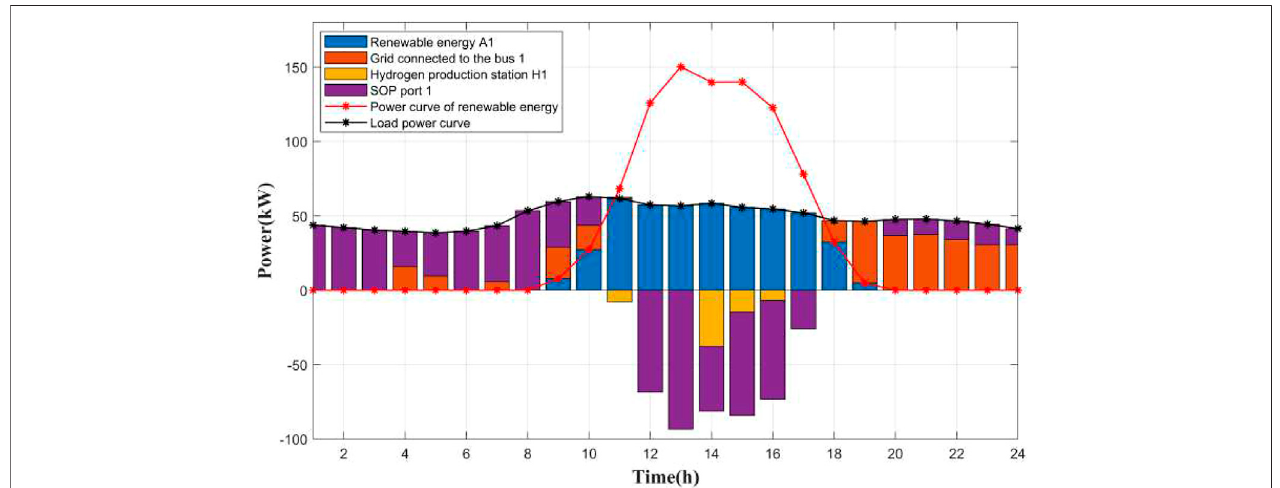
FIGURE 12 | Operation of bus